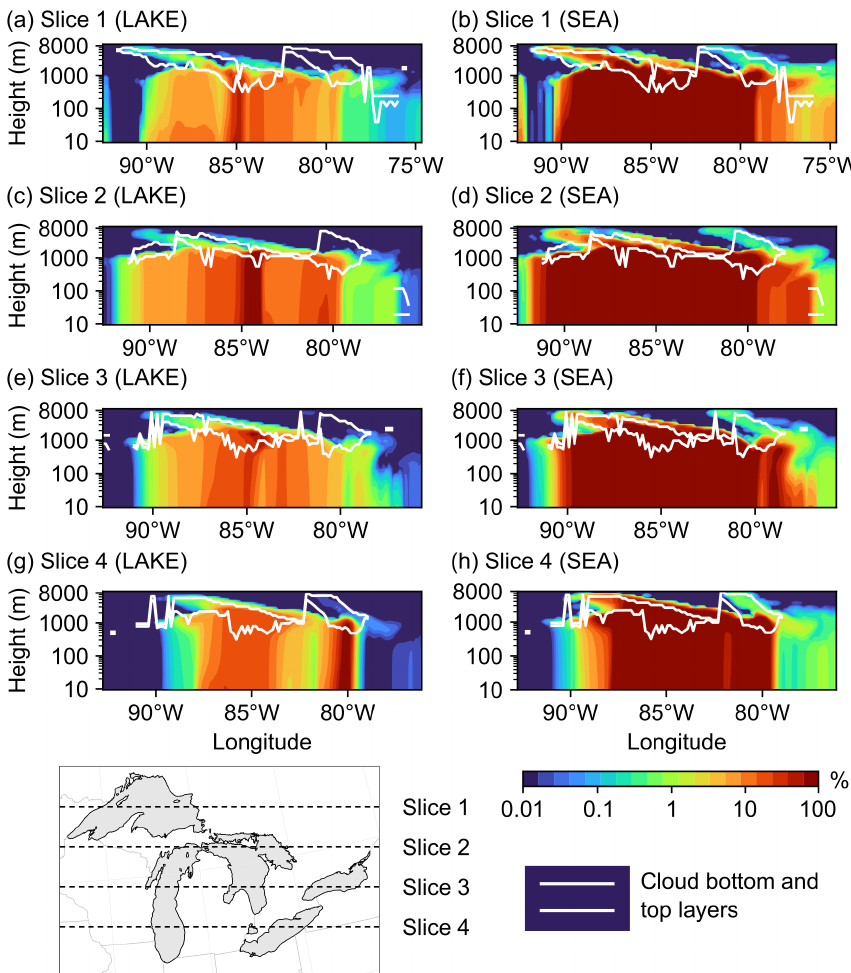
Figure 12. Same as Fig. 11 but for coarse-mode